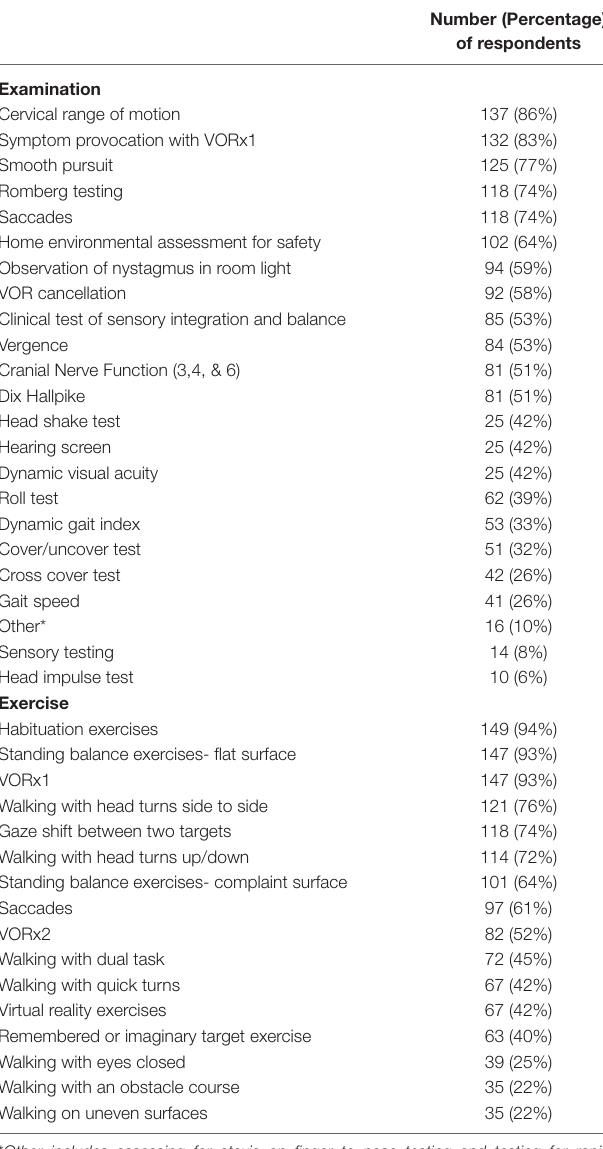
TABLE 3 | Barriers physical therapists reported when completing telehealth vestibular therapy sessions. Barrier physical therapist encountered during telehealth